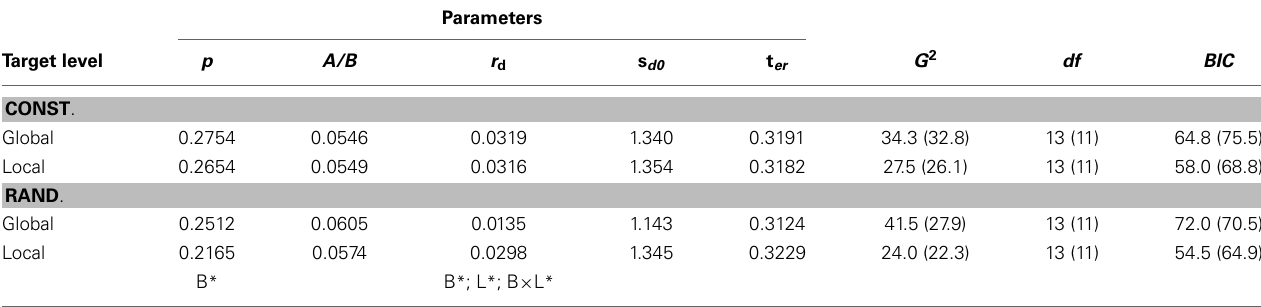
Table 2 | Parameter estimates obtained by fitting the SSP model to the distributional data of the four conditions in the experiment. Parameters